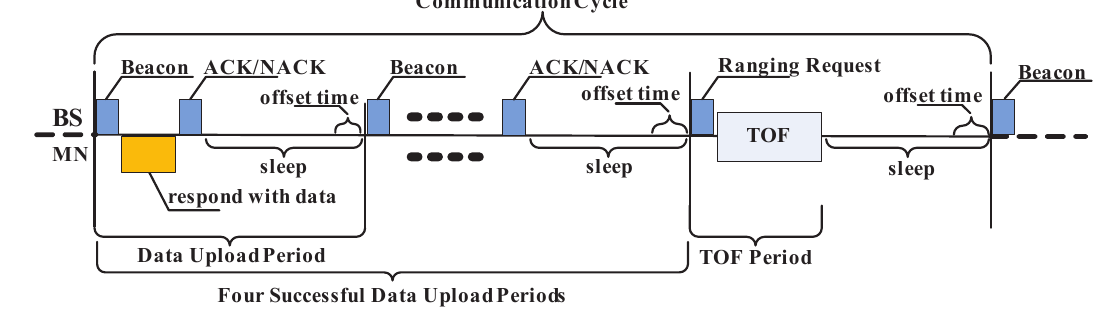
Figure 5. Timing diagram in the communication